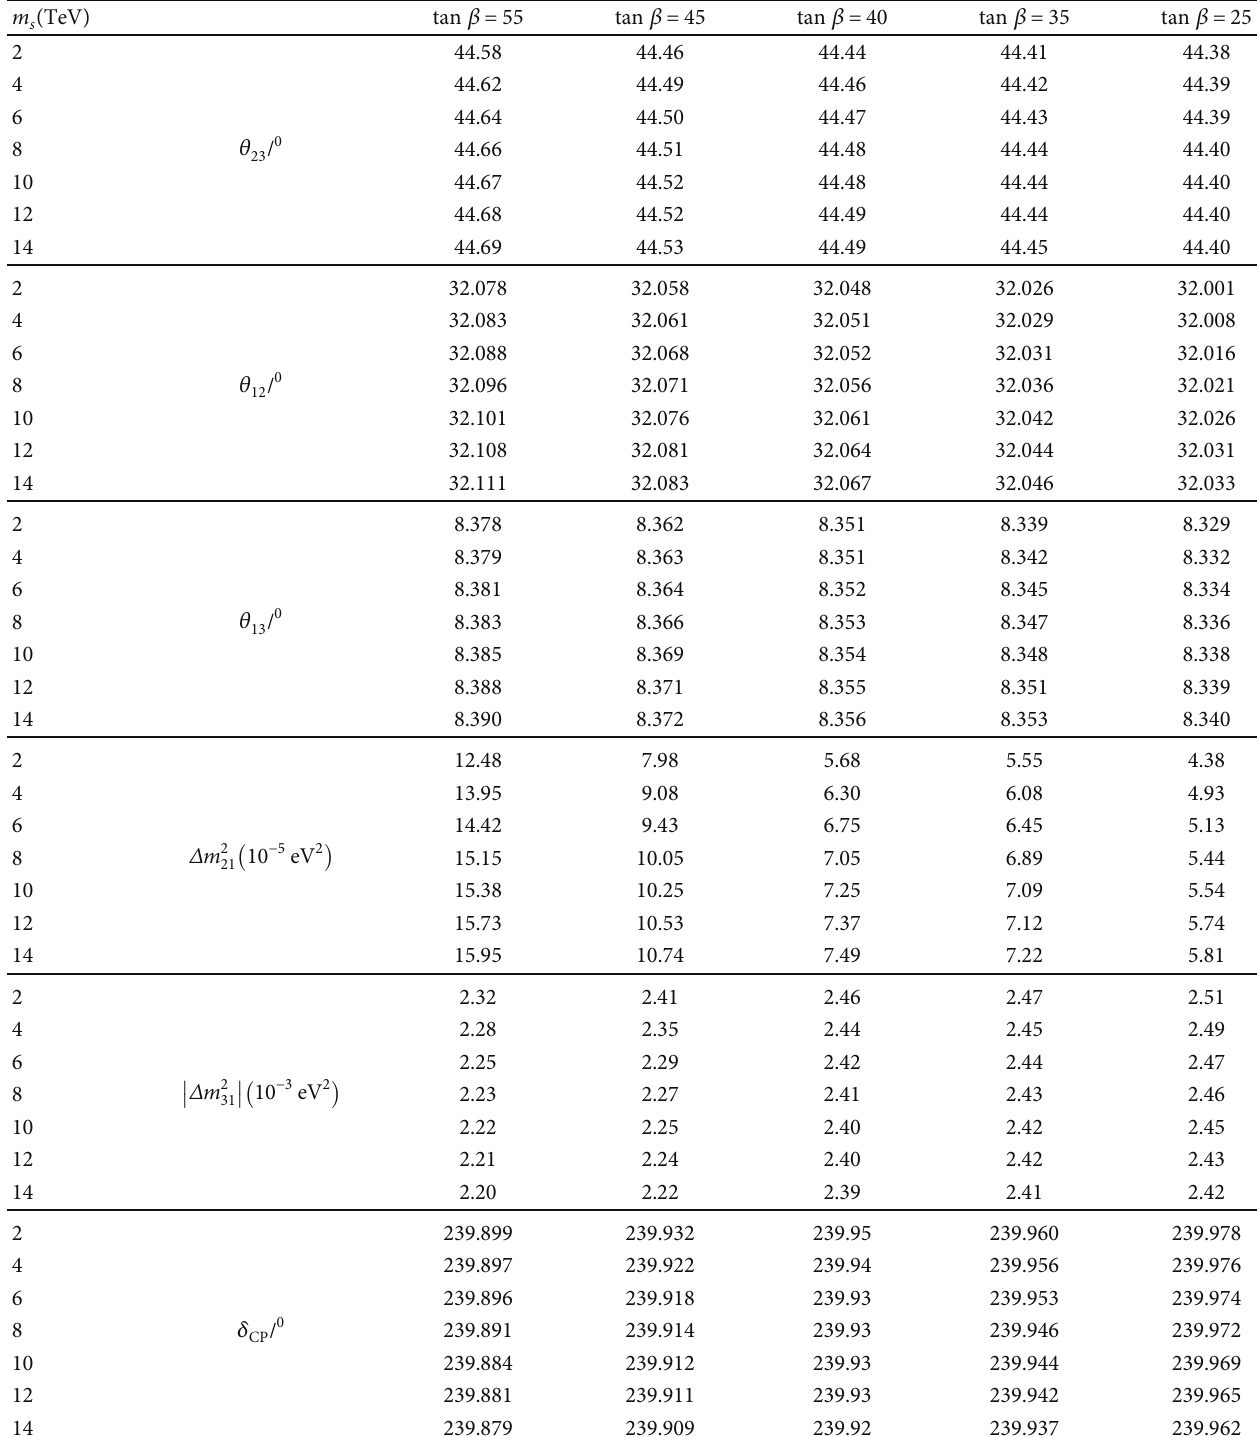
and tan β for IH case ( M s